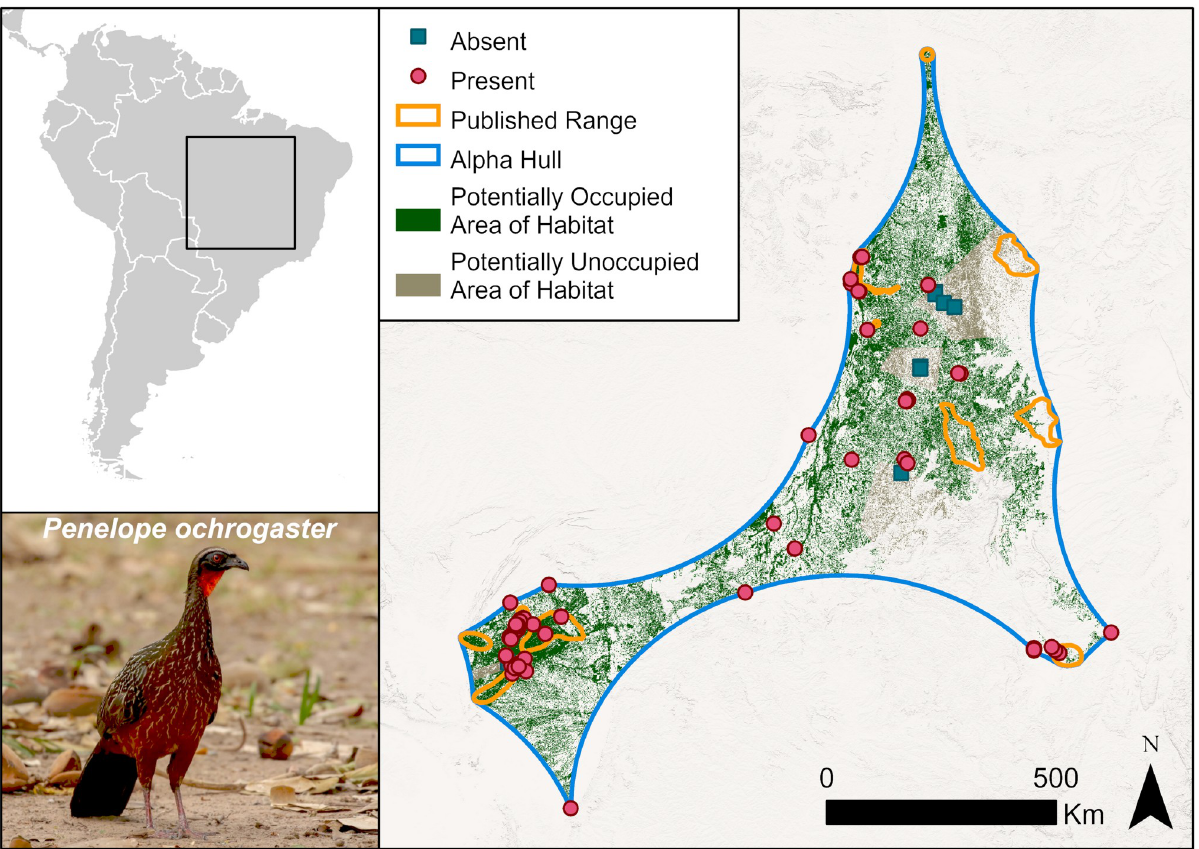
Fig 5. Distribution of the chestnut-bellied guan, Penelope ochrogaster . eBird records illustrate that the range of P . ochrogaster expands beyond the published range. Symbology is simplified to show absences (blues squares) as the centroids of absence grid cells. Base map provided by USGS and photo by Carlos Sanchez with